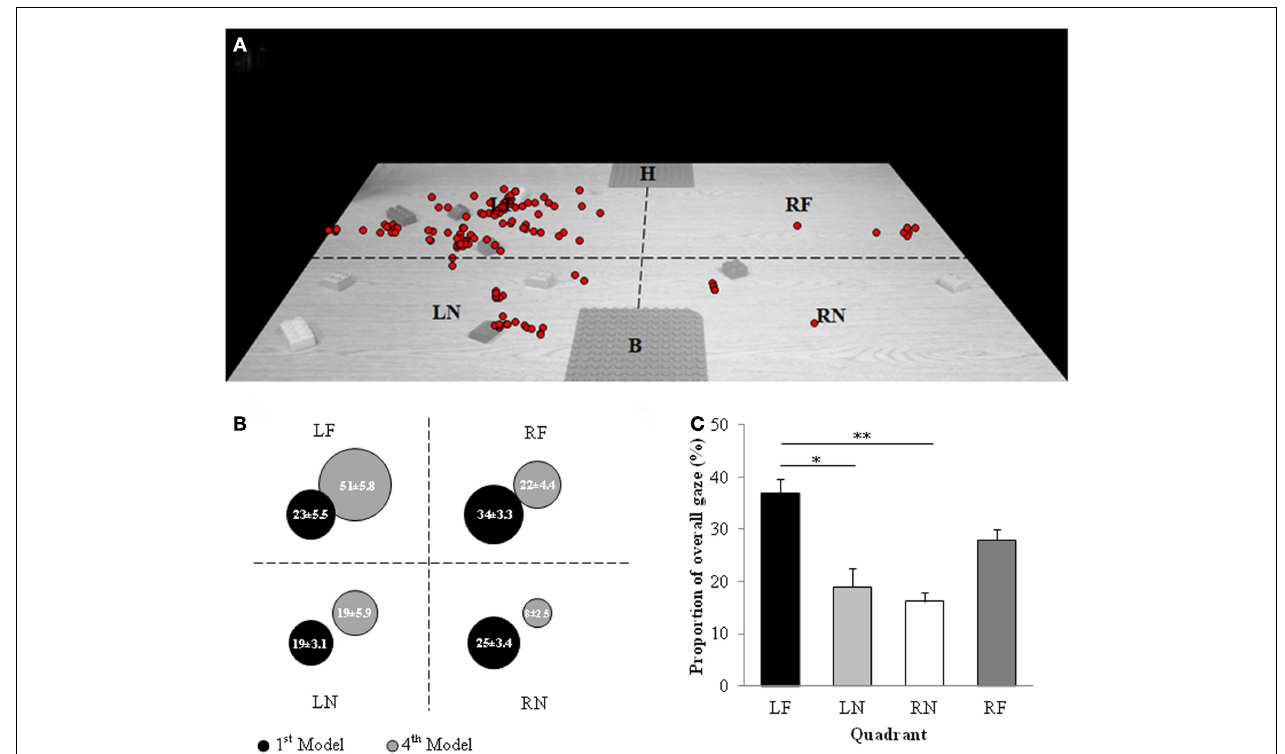
near “build” base plate “B.” (B) Representation of the proportion of gaze (%) directed toward each quadrant of reachable space during construction of the first and fourth models in the model set. Data are means and standard errors. (C) Overall proportion of gaze directed to each quadrant of space. Data are means and standard errors. * p < 0.05, ** p < 0.01, *** p < 0.001 with respect to LF.